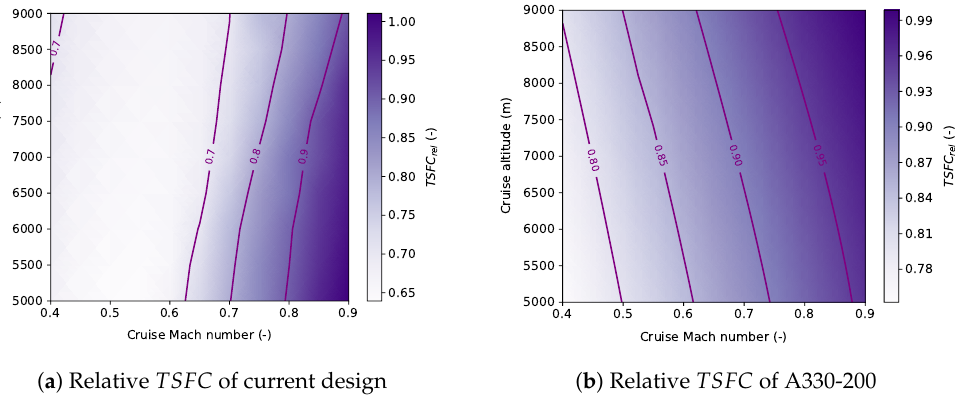
Figure 8. Variation of TSFC with Mach number and altitude (relative to A330-200 at Mach 0.82 and 11,250